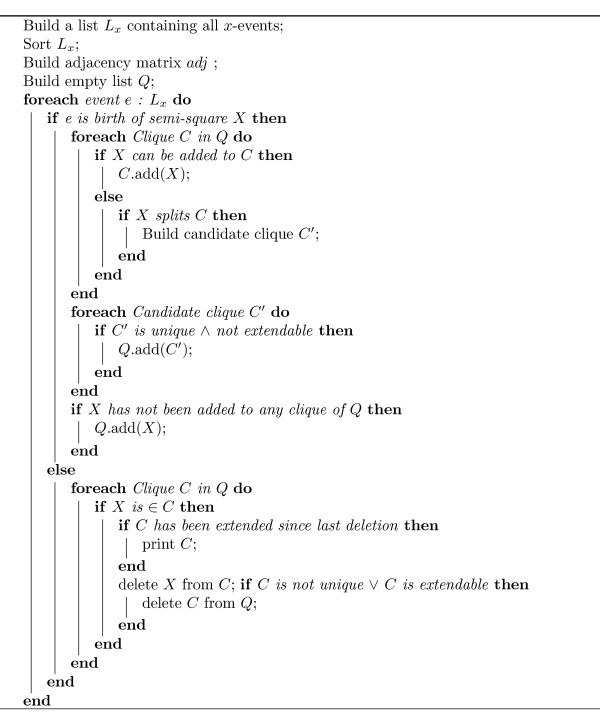
Algorithm for computing all maximal cliques.